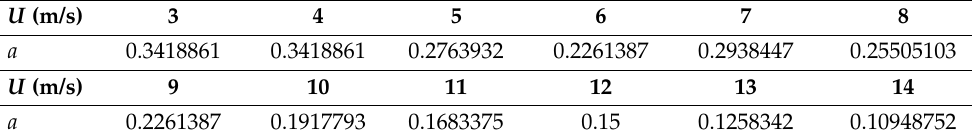
Table 4. Turbine axial data ( U in to U r ).